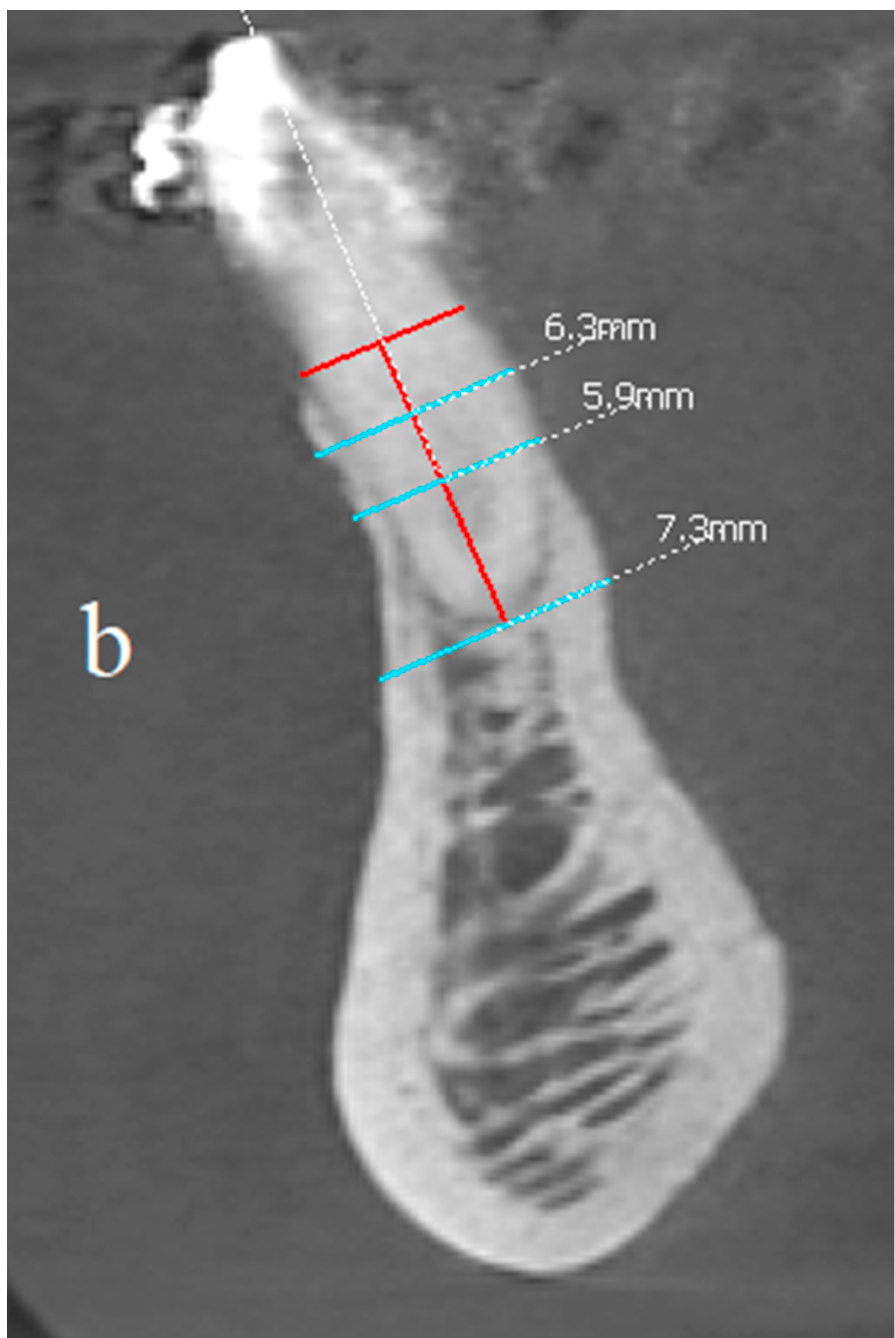
Figure 13. ( a , b ) Comparison of the CBCT scans (sagittal view) before the procedure and two years after the surgical treatment. Before and after images at the same location, the same threshold level is used.